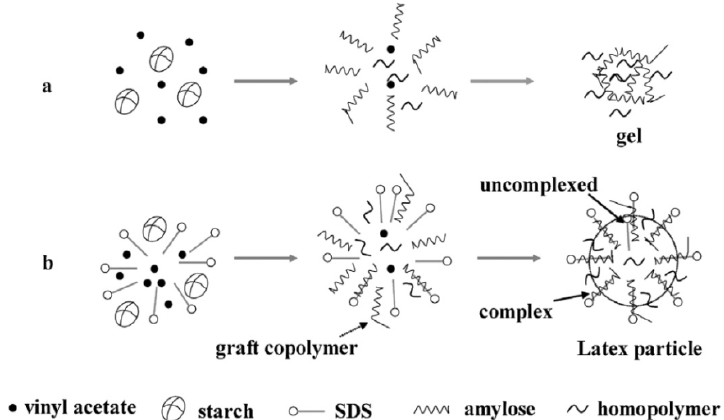
Figure 4. Schematic of the starch-based wood adhesive’s amylose-SDS complexes: ( a ) without and ( b ) with SDS [76]. ( b ) with SDS